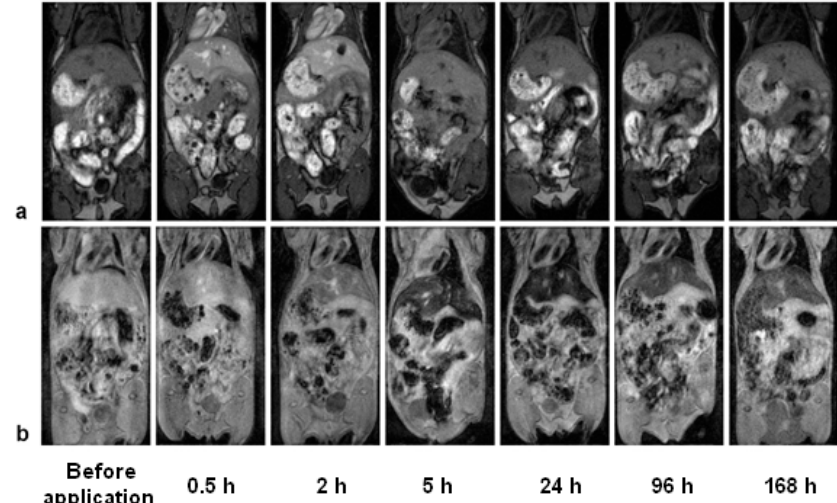
Figure 9. ( a ) T 1 -weighted and ( b ) T 2 *-weighted MR images of the mouse before retroorbital admi-nistration of GdF 3 :Tb 3+ ,Yb 3+ ,Nd 3+ @P(DMA-AGME)-Ale nanoparticles and in several time intervals after the administration. ( a ) The signal in the liver on the T 1 -weighted image substantially increased shortly after the administration due to a strong T 1 effect, while ( b ) the signal on the T 2 *-weighted MR image in the liver and spleen decreased due to nanoparticle accumulation in the organs. Slow excretion of the nanoparticles from the liver was observed after one day